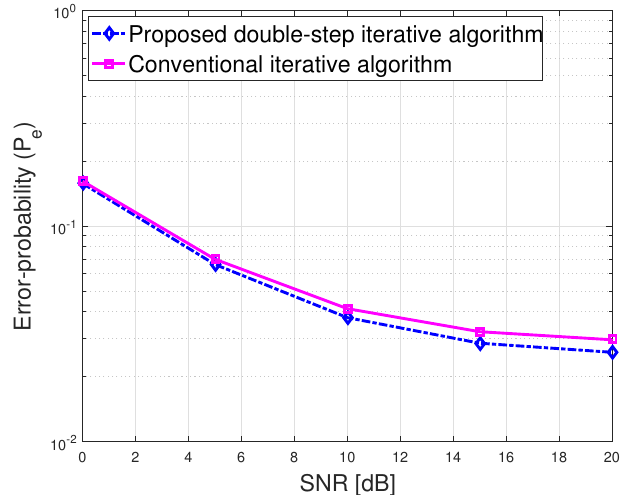
Figure 7. The error−probability performance of the V2V communications at 20 dB